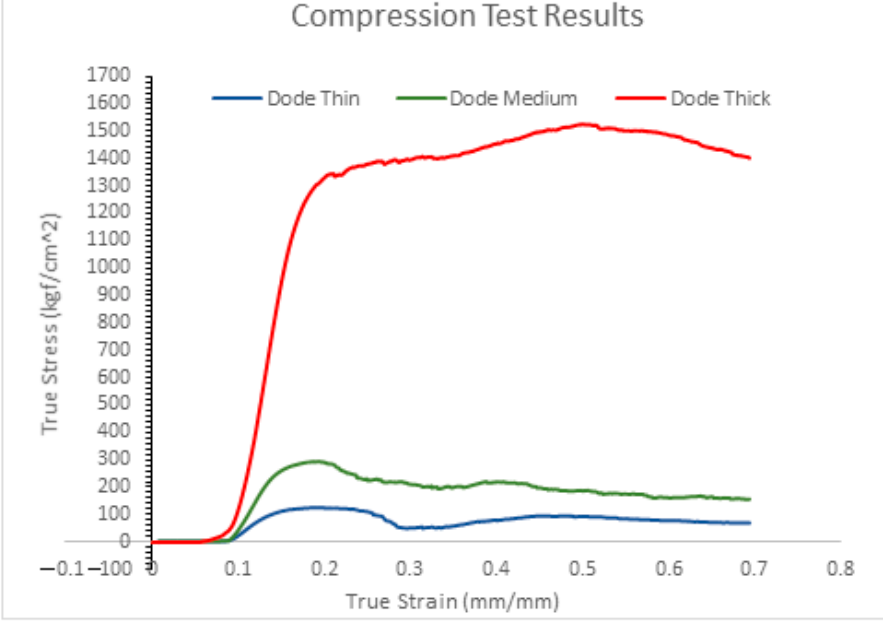
Figure 12. True stress and strain curves from the compression test results of scaffold structures.